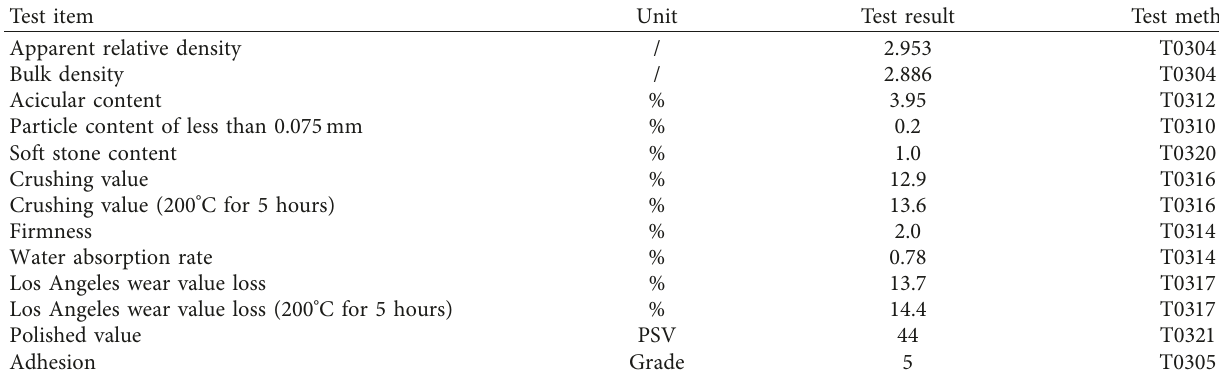
Table 3: Properties of coarse